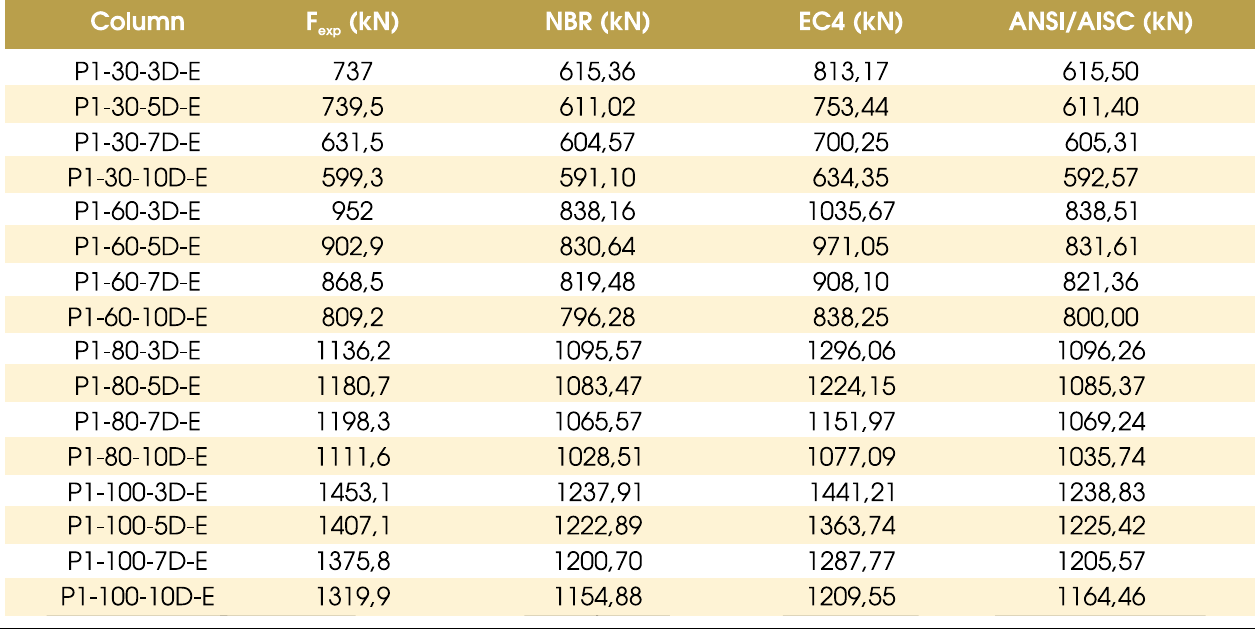
Results are presented in Figure 2 and in Table 5. Figure 2 shows the correlation between model error and the studied variables for the 32 tested columns. Figure 2a reveals a negative correlation between model error and slenderness ratio, (L/D), for the Brazilian code. Since model error has a positive bias in this code, this covari - ance shows that bias is reduced as slenderness increases, and the model shifts towards the correct result (unitary model error mean) as slenderness increases. This occurs because the design equation converges to the exact Euler solution for large